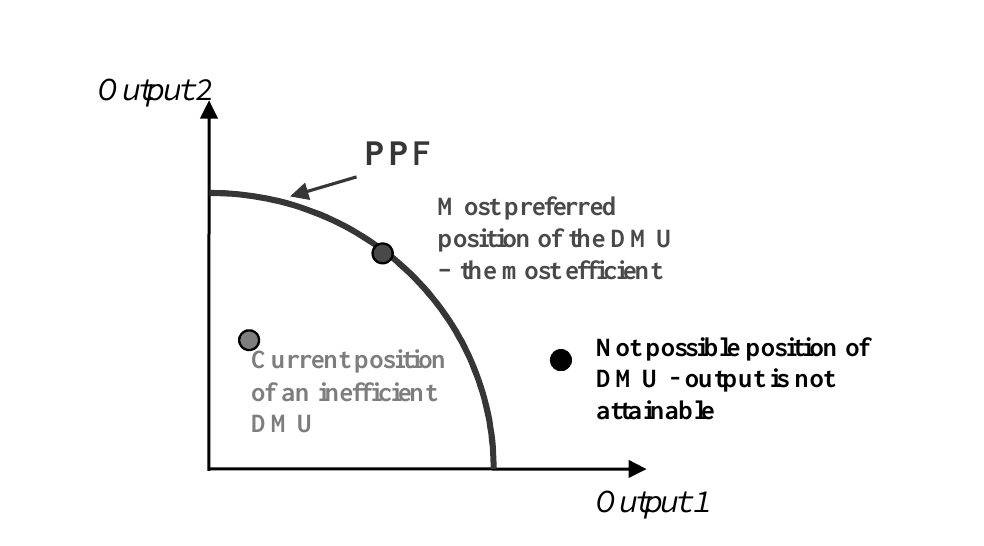
Figure 2 – Illustration of a possible location of the most preferred future position of the